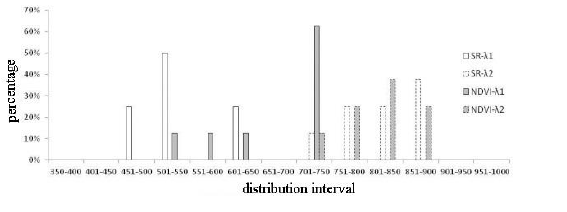
Figure 3 : Distribution of SR and NDVI indices’ band center